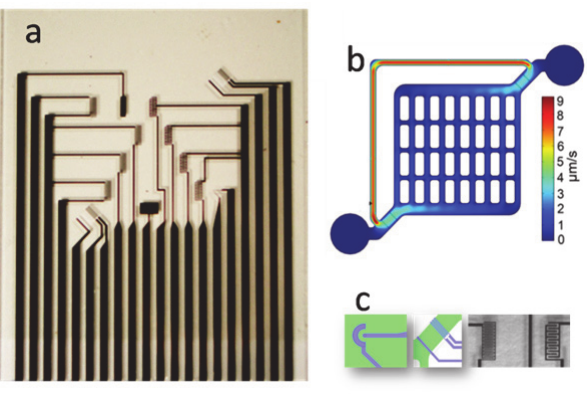
Fig. 16: (a) Glass cell-culture chip (size: half a microscopic slide) with two ETµPs according to Figure 12a (diagonally oriented structures at the lower left and upper right corners), eight IDES for impedance detection of cell adhesion (light rectangular structures), one oxygen sensor (fine structure with two connectors at the lower right) and two pH sensors (dark rectangles at the lower center and in the top row). (b) ETµP-flow simulation in the closed microfluidic poly-dimethyl-siloxane structure. The highest velocity is reached in the back-flow path. (c) All sensors and pump structures were located in the fluid channels. From the left: oxygen sensor, ETµP, two 1.4 x 0.5 mm 2 IDES with 30 µm and 50 µm